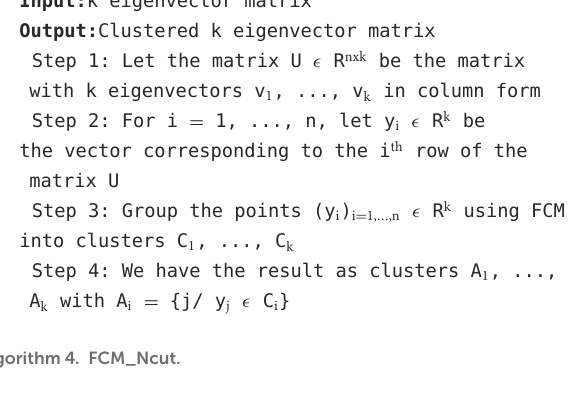
TABLE 1 The number of clusters from an image by intuition and K-segment_Histogram algorithm on using histogram. Data set